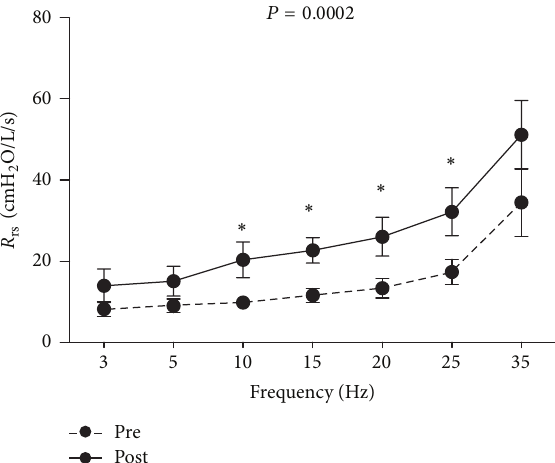
Figure 3: Plots of mean values for respiratory resistance (𝑅 10Hz to 25 Hz before (pre) and after (post) bethanechol for each piglet. 𝑃 = 0.018 , paired 𝑡 -test one tailed for the average.